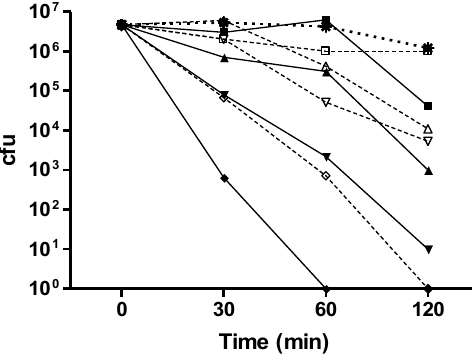
Figure 1. Time-kill curves with CuAL42 and CuPC33 on the antibiotic-sensitive H. pylori strain, J99.Star, control; closed square, CuAL42 0.5 mg/L; closed triangle, CuAL42 1 mg/L; closed upside-down triangle, CuAL42 5 mg/L; closed diamond, CuAL42 12 mg/L; open square, CuPC33 0.5 mg/L; open triangle, CuPC33 1 mg/L; open upside-down triangle, CuPC33 5 mg/L; open diamond, CuPC33 12 mg/L. The results shown are the means of triplicate observations. Error bars representing standard deviations (less than 10%) are not shown for reasons of clarity.